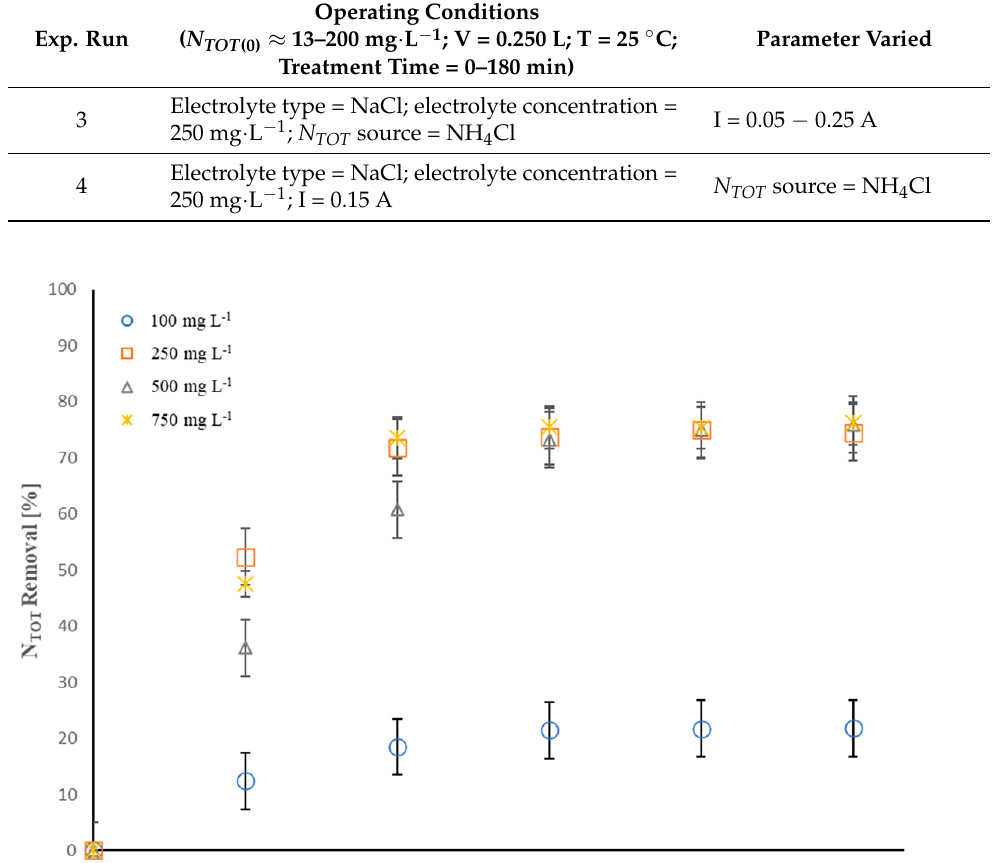
Table 1. Experimental conditions.